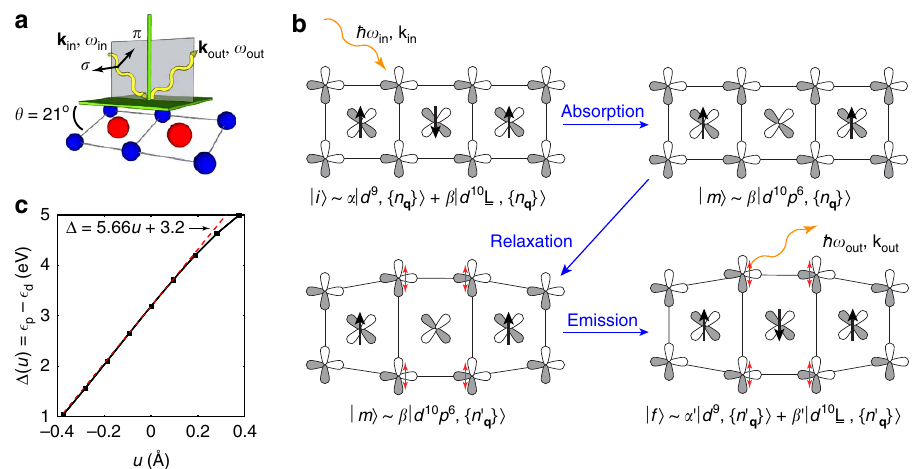
Figure 1 | A cartoon sketch of the RIXS process. ( a ) A sketch of the experimental scattering geometry, showing the scattering plane (grey plane) perpendicular to the sample surface (green plane), making an angle of 21 (cid:2) with the CuO 2 chains, depicted here as a Cu 2 O 6 dimer (Cu in red and O in blue). The wavy lines represent the incoming and outgoing photons while the black arrows indicate the polarization of the incoming photons with respect to the scattering plane. ( b ) A sketch of the RIXS excitation process whereby the lattice is excited. The initial electronic state is predominantly of | i i el B a | d 9 iþ | d 10 L i character, where L denotes a hole delocalized on the ligand-oxygen sites, while the initial lattice state involves a coherent state of phonon quanta jf n q gi describing the shifted equilibrium position of the O atoms. The thick black arrows represent the spins of the Cu 3d holes in the LCO ph chain. After the 1 s - 2 p transition, an intermediate state of m j i b d 10 (cid:2) (cid:2) (cid:3) character is formed, corresponding to an upper Hubbard band excitation where el (cid:3) the number of holes on the Cu site has changed. Following this, the lattice relaxes in response to the change in Cu density, until the 1 s core hole is filled, . The red arrows indicate the direction of the O atom’s motion. ( c ) The variation leaving the system in an excited electronic and lattice configuration jf n 0 q gi ph of the CT energy D ¼ E p (cid:2) E d as a function of a static compression u of the Cu–O chains in a direction perpendicular to the chain direction. Crystal field effects have been neglected. The black points are the calculation results while the red dashed line is a linear fit to these data at small